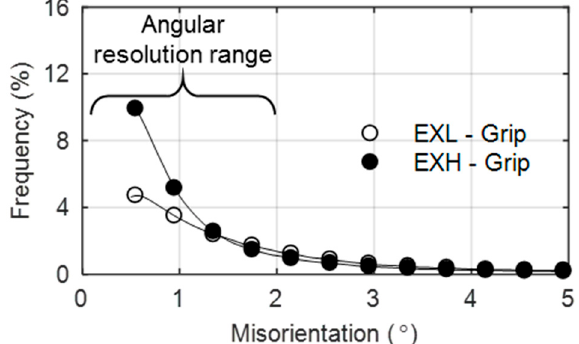
Figure 9. Distribution of misorientation angles (<5°) in EXL and EXH showing a higher frequency of subgrain (<1°) boundaries in EXH grip material.